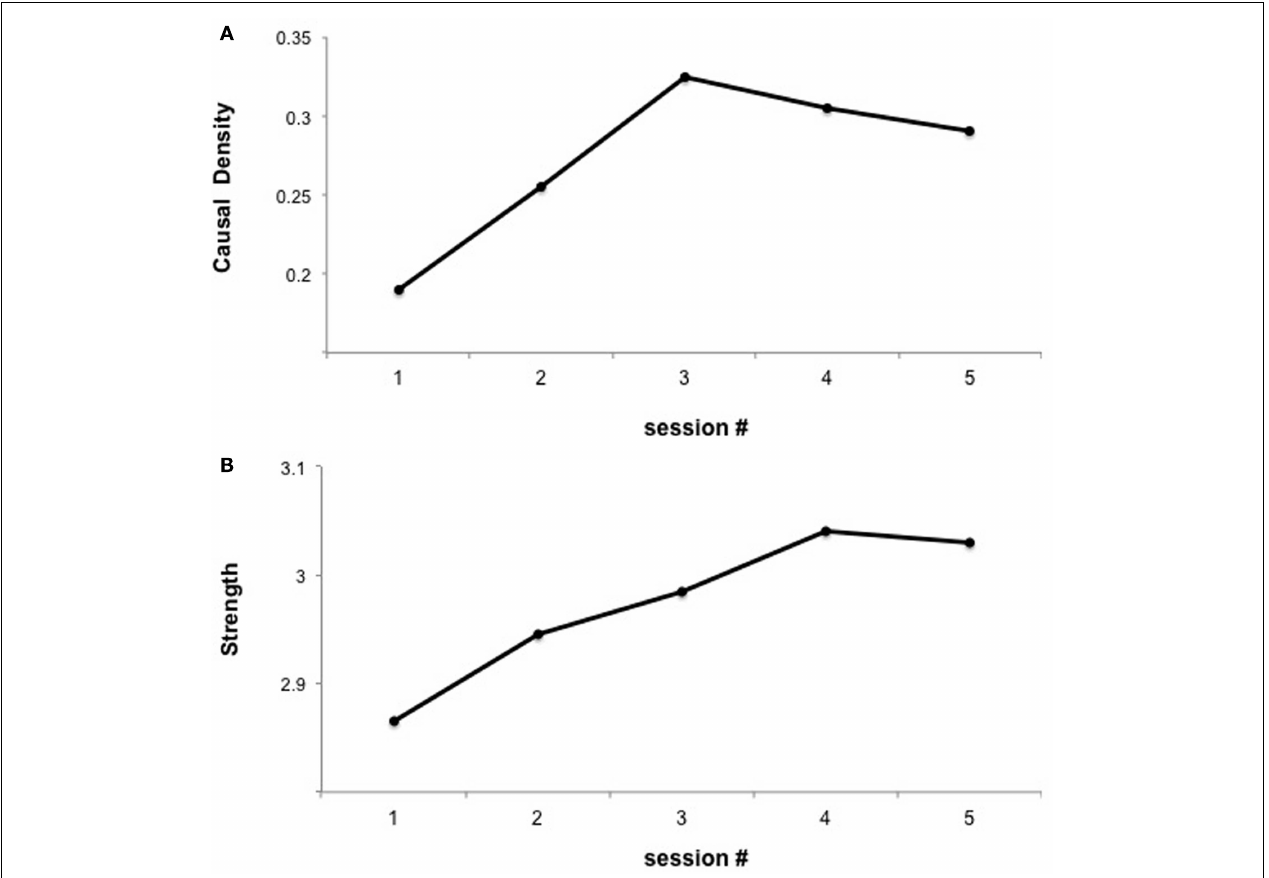
causal density of the functional network decreases in session 5 indicating substantial “pruning” [as shown in (A) ] yet “strengthening” [as shown in (B) ] of the connections between ROIs reproduced with permission from Lee et al.